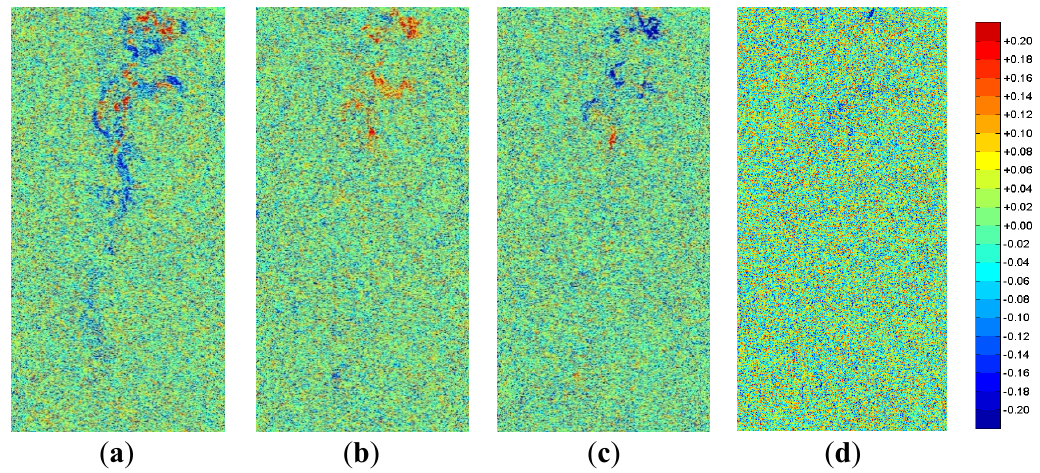
Figure 4 . Cloude-Pottier anisotropy changes between sequent acquisitions (without unit):